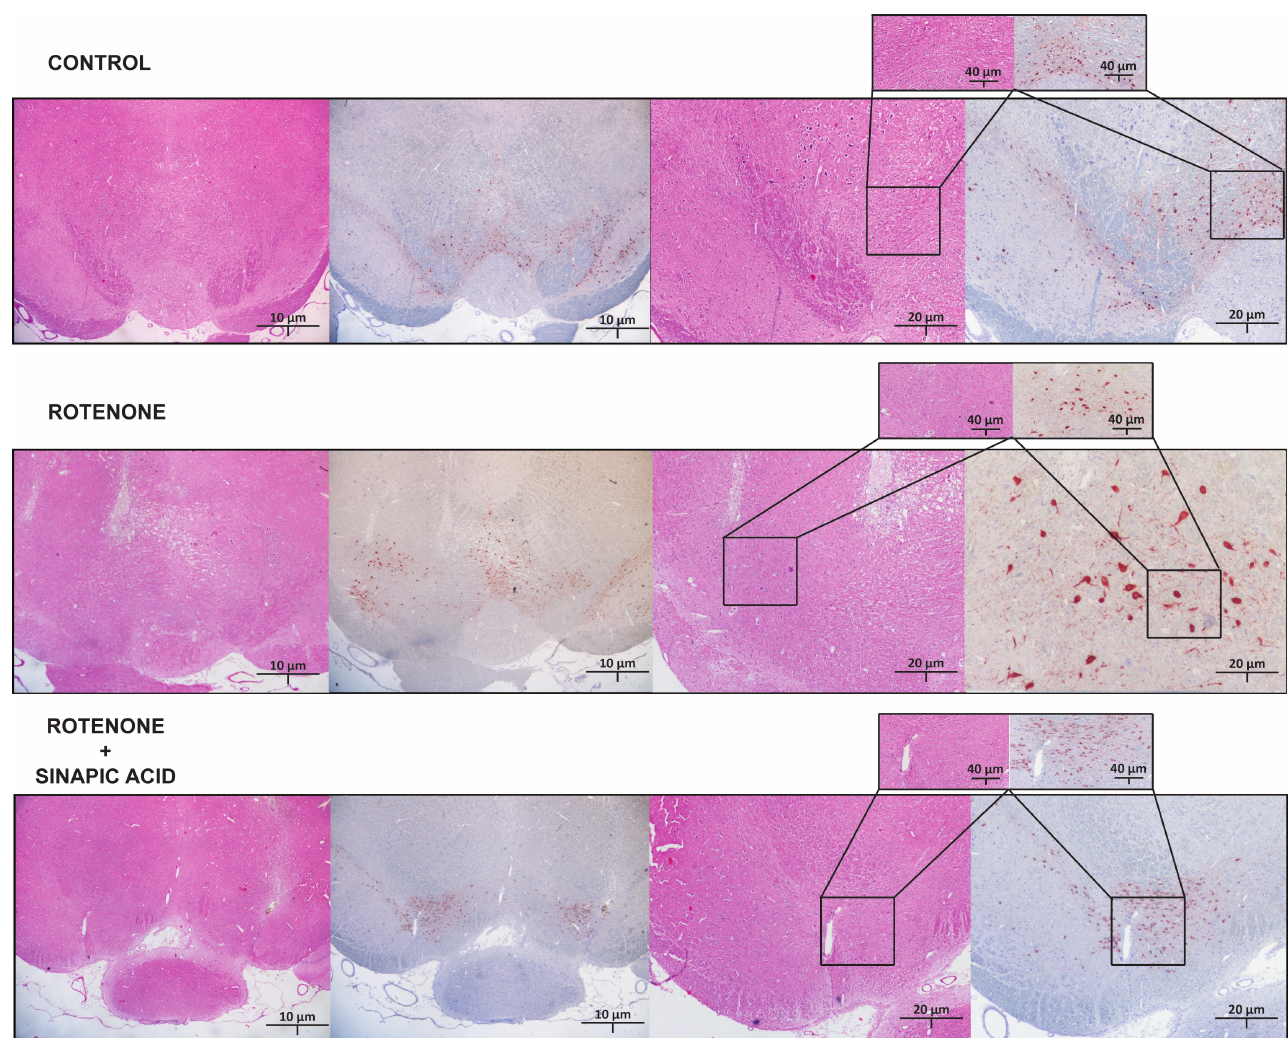
FIGURE 6 - Healthy neurons with TH immunopositivity in the control group. Rotenone injection resulted in neuronal degeneration and intense vacuolations with shrinkage and necrosis. In sinapic acid group, neurons showed slight vacuolization, but these neurons were immunohistochemically positive for tyrosine